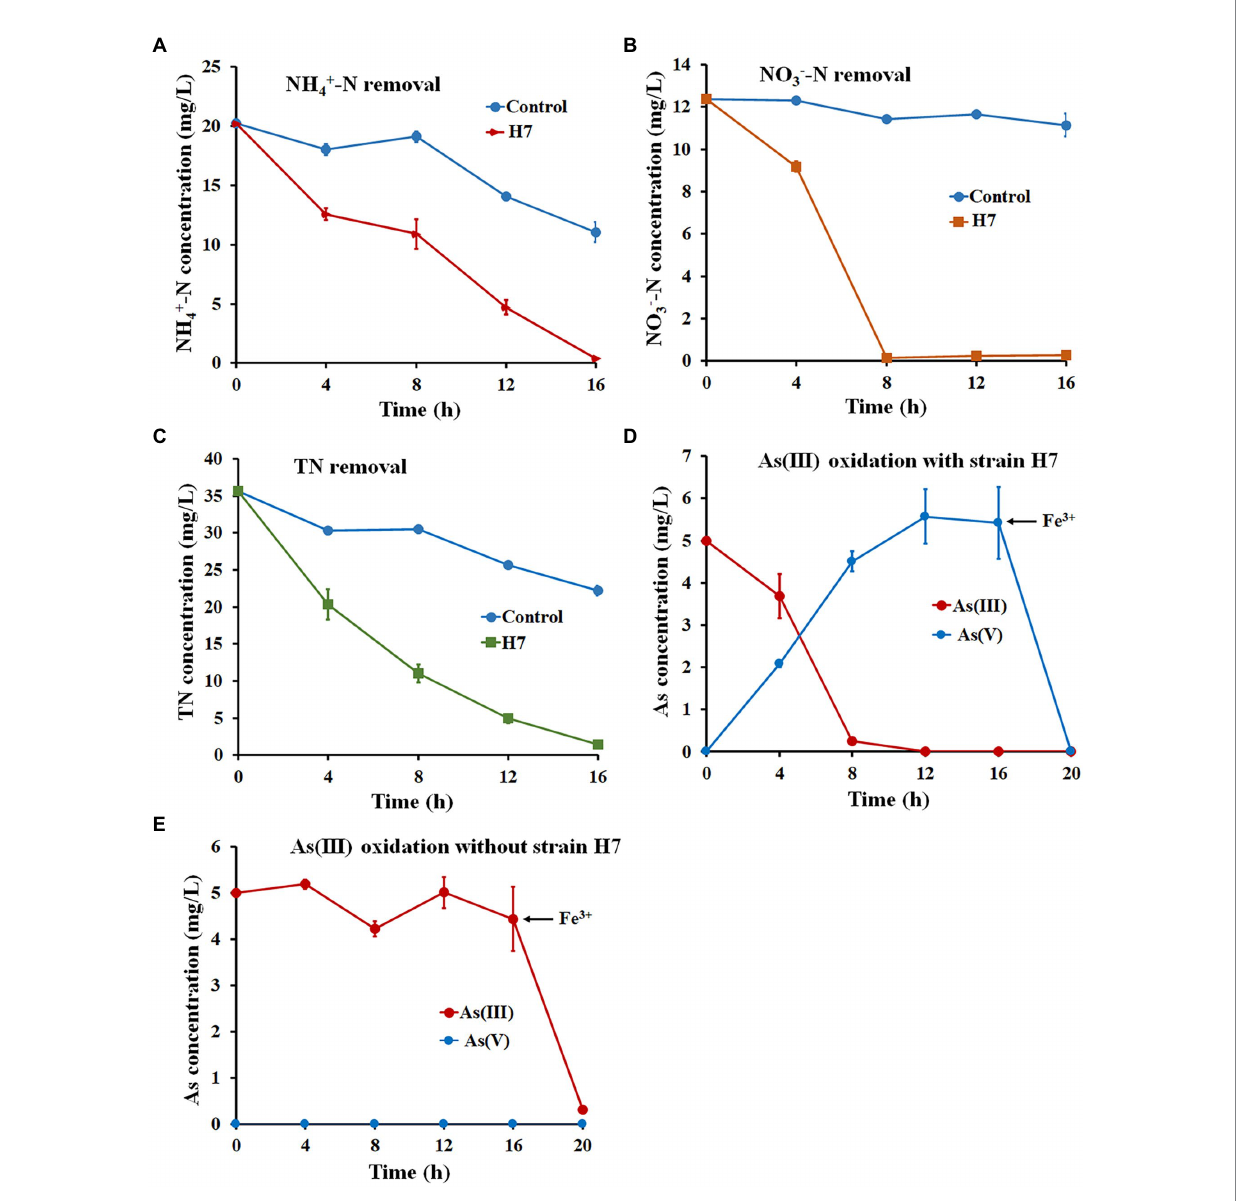
FIGURE 4 Nitrogen and As(III) removal by strain H7 combined with Fe 3+ in wastewater. The removal curve of NH 4+ -N (A) , NO 3 − -N (B) , and TN (C) by strain H7. (D) The oxidation and removal curves of As(III) with the addition of strain H7. (E) The oxidation and removal curves of As(III) without adding strain H7. Error bars represent the mean ± standard deviation (n =